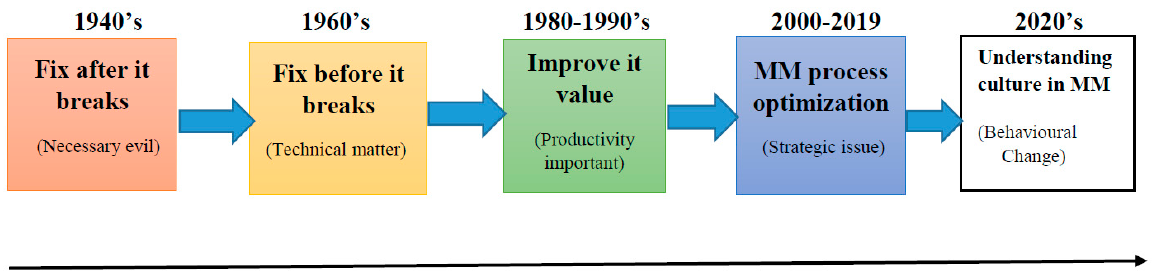
Figure 3. Changing maintenance management